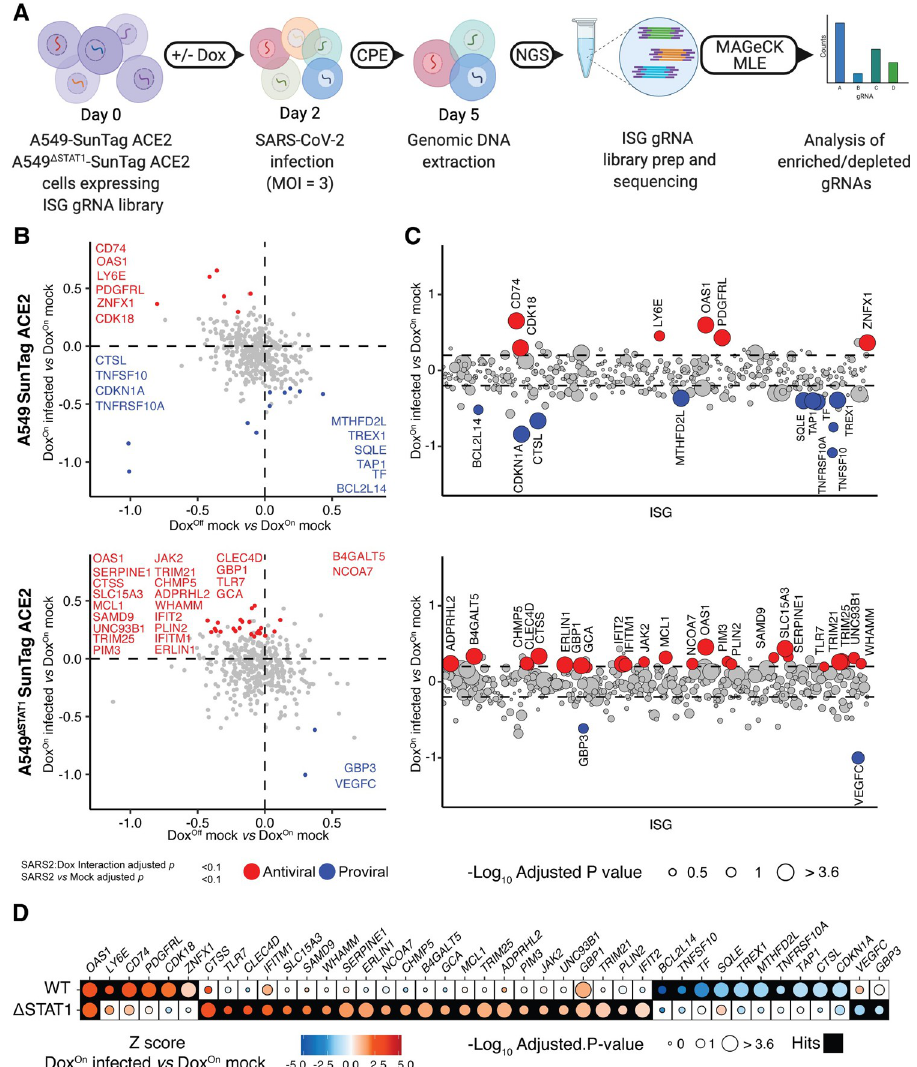
Fig 2. Inducible CRISPRa ISG screen for SARS-CoV-2 restriction factors. (A) Schematic of inducible CRISPRa ISG screens for SARS-CoV-2: Single cell clones of A549-SunTag ACE2 and A549 Δ STAT1 -SunTag ACE2 cells were transduced with a library of 1,266 gRNAs and infected with SARS-CoV-2 (M.O.I. = 3, 72 hours). After onset of SARS-CoV-2 CPE, genomic DNA was extracted from surviving cells, and enriched/depleted gRNAs were evaluated by high throughput sequencing followed by MAGecK MLE analysis. (B) MAGeCK-MLE analysis of SARS-CoV-2 ISG screens in A549-SunTag ACE2 and A549 Δ STAT1 -SunTag ACE2 cells. Plot depicts MAGeCK MLE β scores for Dox status coefficient (Dox Off mock infected vs Dox On mock infected, x-axis), and SARS-CoV-2 infection status coefficient (Dox On SARS-CoV-2 infected vs Dox On mock infected, y-axis). ISGs passing significance selection filters (SARS-CoV- 2 infection status adjusted p value and SARS-CoV-2:Dox interaction adjusted p value < 0.1) are highlighted in red/ blue for “antiviral”/“proviral” effects, respectively. SARS-CoV-2 restriction factors and antiproliferative genes are labeled with gene symbols. (C) MAGeCK-MLE analysis of SARS-CoV-2 ISG screens in A549-SunTag ACE2 and A549 Δ STAT1 -SunTag ACE2 cells, aligned by ISG. MAGeCK MLE β scores for SARS-CoV-2 infection status coefficient (Dox On SARS-CoV-2 infected vs Dox On mock infected) are plotted for each ISG (x-axis, alphabetical order); dots are sized according to significance of SARS-CoV-2:Dox interaction coefficient (-Log 10 adjusted p value) and highlighted in red/blue as in (B). Dashed line indicates ± 1 standard deviation of SARS-CoV-2 infection status coefficient β scores. (D) Comparison of candidate “antiviral”/“proviral” ISG hits passing significance filters in at least one (A549-SunTag ACE2 or A549 Δ STAT1 -SunTag ACE2) genotype. Dots are shaded by ISG Z-scores for SARS-CoV-2 infection status coefficient (Dox On SARS-CoV-2 infected vs Dox On mock infected), and sized according to the significance of SARS-CoV-2:Dox interaction coefficient (-Log 10 adjusted p value). Filled boxes indicate ISG passing significance filters for the indicated screen.